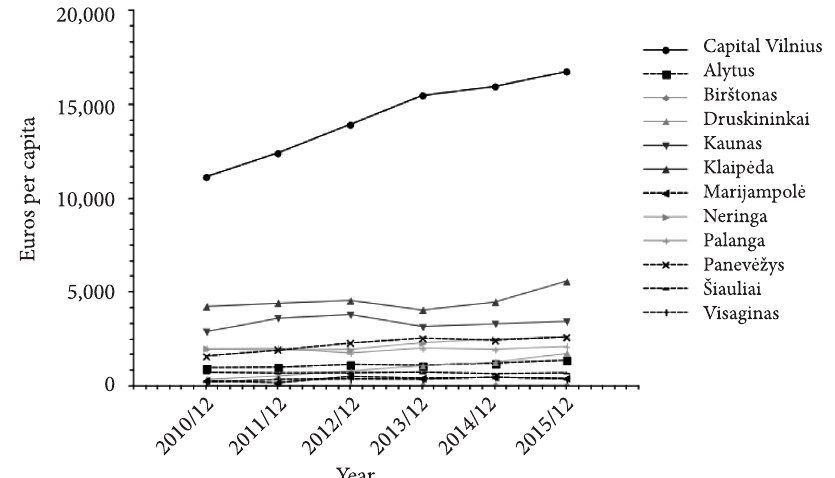
Figure 1. FDI per capita dynamic in Lithuanian cities (made by authors according to Statistics Lithuania,